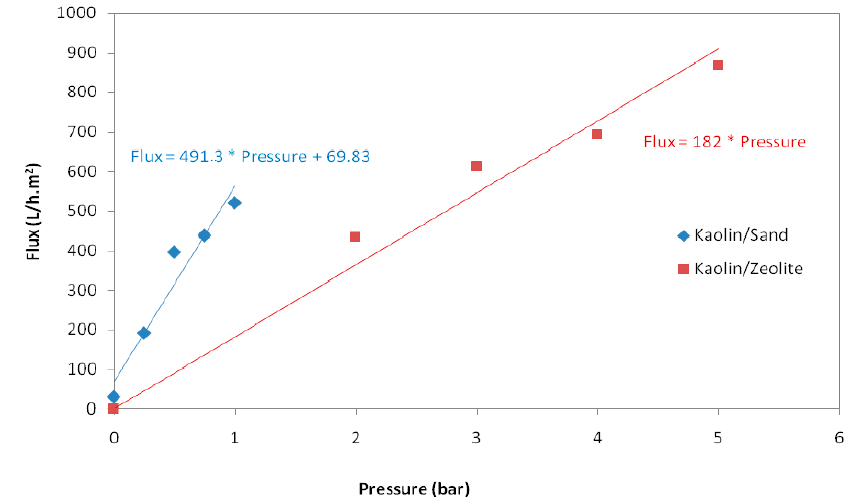
Figure 5. Evolution of water permeate flux of kaolin/sand and kaolin/zeolite membranes with pressure.